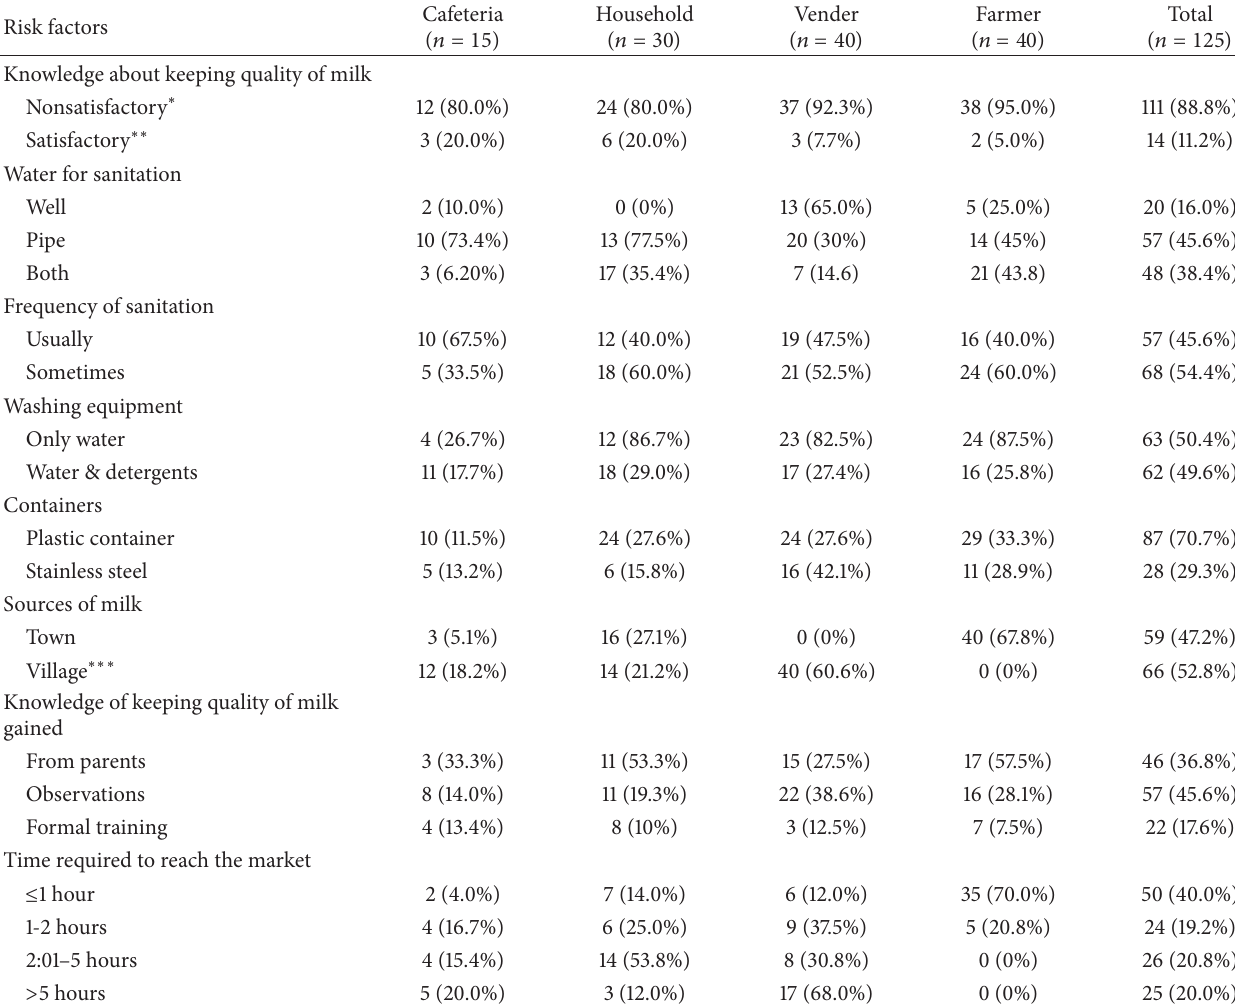
Table 4: Summary of questionnaire